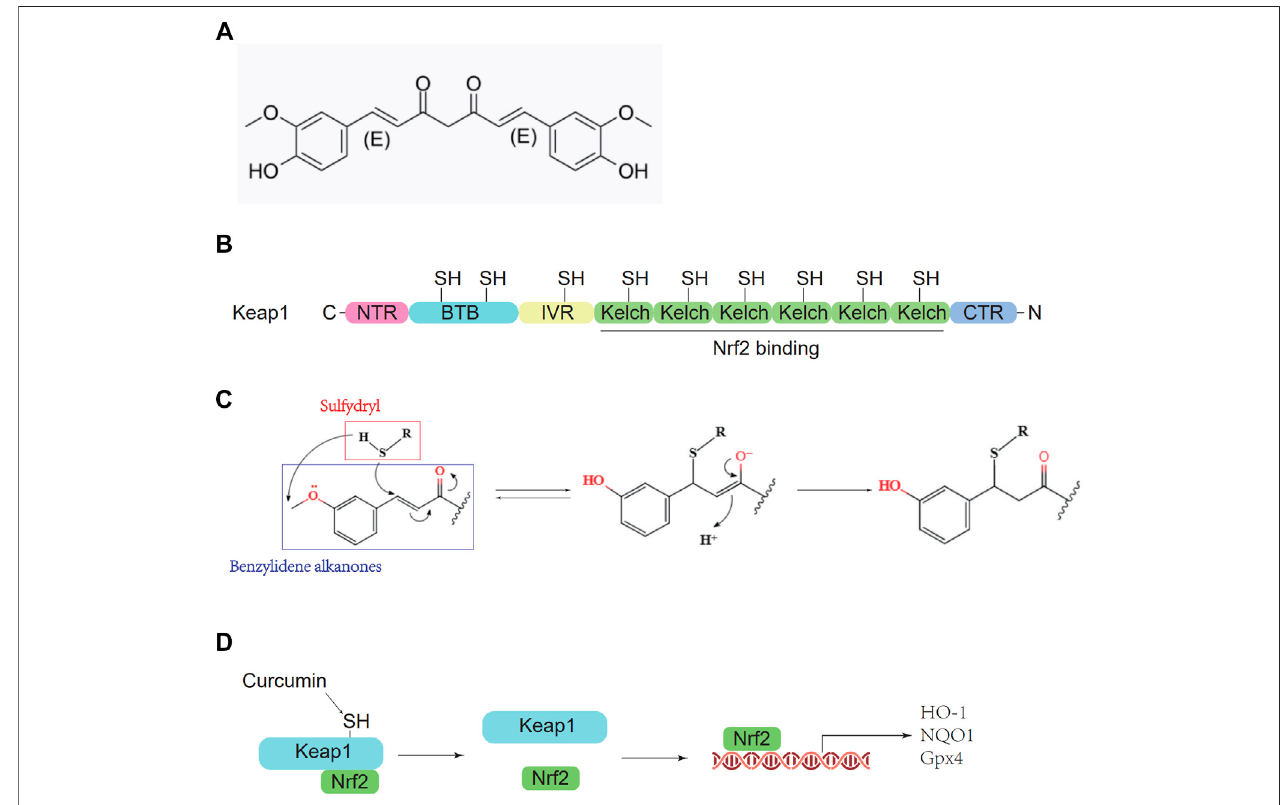
FIGURE 1 | Pharmacological molecular mechanisms of curcumin. (A) The chemical structure of Curcumin. (B) Domain architecture of Keap1. (C) Chemical reaction sketch described curcumin ’ s enhanced reactivity of the SH group. (D) Curcumin inhibits Keap1 capture and binds Nrf2.